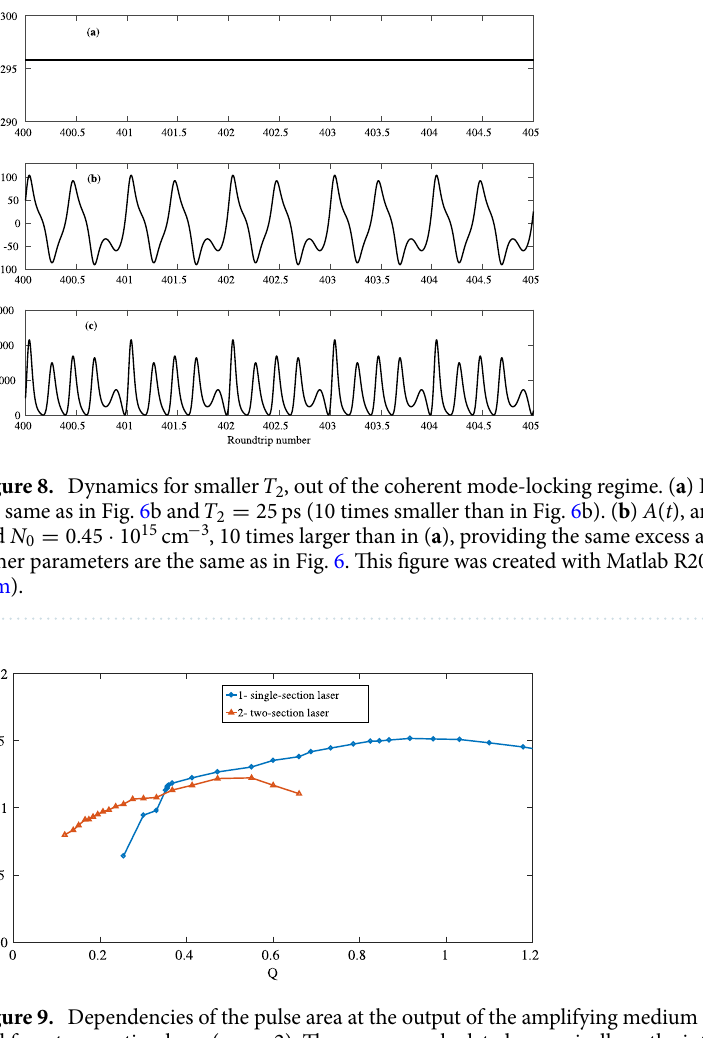
the pulse duration, as given by numerical simulations, increases, since, due to decrease the pump rate N 0 / T 1 , the overall power also decreases. Furthermore, we compared our simulations of a single-section laser with a laser, containing both an ampli- fier and absorber and working in the CML regime. The length of the absorber section was taken to be the half of the length of the amplifier, the concentration was three times less than in the amplifier section, and the dipole moment was twice larger. This twofold difference in the dipole moments is necessary for the implementation of coherent mode-locking in a two-section laser 7 . The relaxation times were taken as: T 1 = 0.2 ns, T 2 = 0.1 ns. In contrast to a single-section laser, self-pulsations start at the higher pump level and exist in the range from Q = 0.57 to Q = 0.1 (see Fig. 7, curve 2). After that, the mode-locking regime becomes unstable, and several pulses appear in the generation. With further increase of N 0 , harmonic mode-locking was observed. As in the case of a single-section laser, the instability zones alternated with harmonic mode-locking zones took place. Comparison of the curves 1 and 2 in Fig. 7 shows that in the given example, the minimum pulse durations in the mode-locking regime differ 3 times between single- and two-section lasers. That is, an absorber allows to reduce the pulse duration, in comparison to the single-section laser without absorber. This happens via more effective preventing the development of “tails” of the pulses that arise in a single-section laser, that is, via bet- ter protecting the non-lasing background after the pulse against perturbations. However, the achievable decrease of the pulse durations is not so dramatic, as it could be expected. In both cases, the area of the pulse after the amplifying medium in the mode-locking zone was close to π . The corresponding dependence is shown in Fig. 9. The area in Fig. 9 was calculated numerically as the integral over the pulse envelope over the whole roundtrip. Such definition does not allow to determine the area of the pulses when multiple of them are present in the cav- ity. On the other hand, in this way we can continue the definition of the area to the self-pulsing regimes with a small amplitude and even to the CW regime. With a such defined area, numerical simulations revealed another